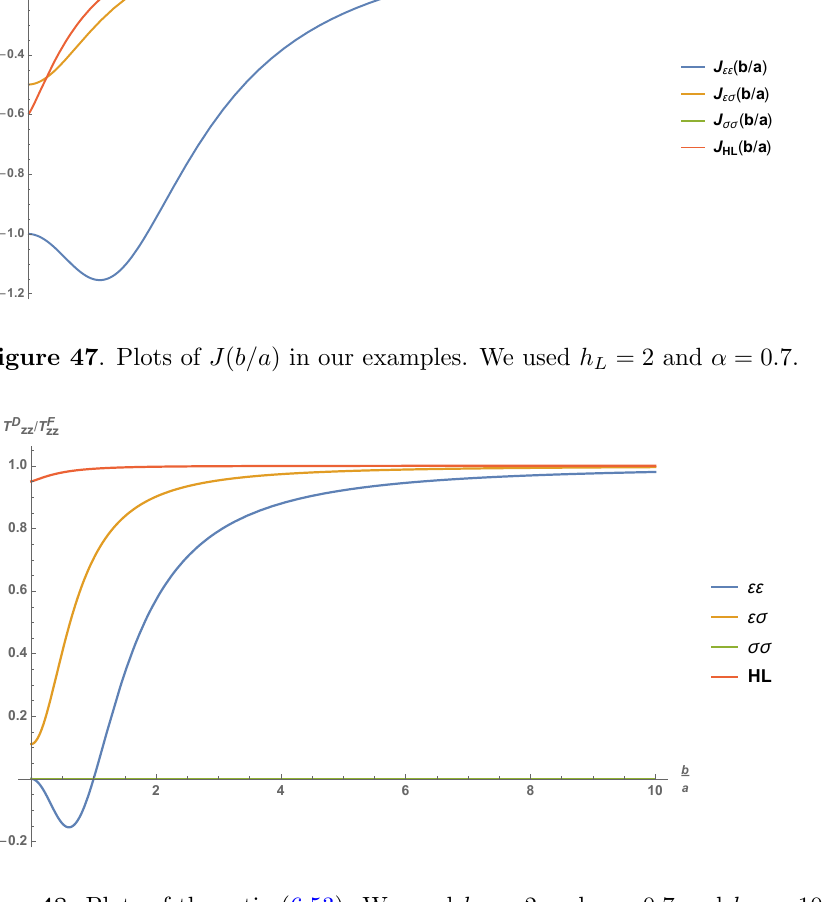
L = 2 and (cid:11) = 0 : 7 and h H = 10.